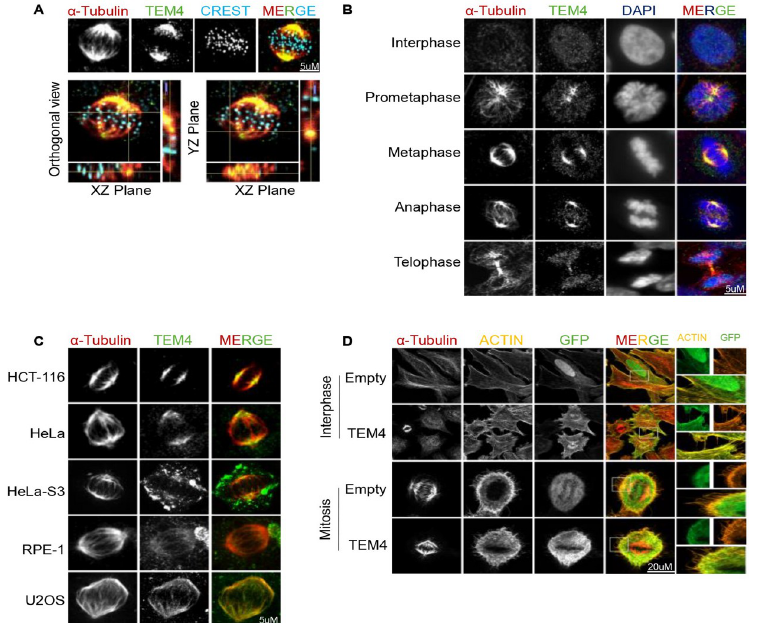
Fig 1. The TEM4 antibody decorates the mitotic spindle. A: Representative immunofluorescence image of a metaphase HCT-116 cell. Cells were synchronized in mitosis after 10 hours of release from double thymidine block and fixed for 10 minutes with PTEMF buffer. Fixed cells were stained with anti-TEM4 (green), anti- α -tubulin for the spindle microtubules (red) and CREST serum for the kinetochores (blue). In the lower panel, orthogonal sections of the maximum intensity projections of the same cell are shown. Scale bar = 5 μ m. B: Representative immunofluorescent images of TEM4 antibody staining in HCT-116 cells during cell cycle progression. Fixed cells were stained with anti- TEM4 (green), anti- α -tubulin (red), and DNA was stained with Hoechst (blue). Cell cycle stages are indicated to the left of each image and merged images are shown in the right most panel. Scale bar = 5 μ m. C: Immunofluorescence of metaphase spindles in different cell lines lines showing staining at the mitotic spindle. Cells were synchronized in mitosis after 10 hours of release from double thymidine block and fixed for 10 minutes with PTEMF buffer. Fixed cells were stained with anti-TEM4 (green) and anti- α -tubulin for the spindle microtubules (red). The different cell lines are indicated to the left of each image. Scale bar = 5 μ m. D: HeLa T-REx cells were left synchronous (upper panel) or were synchronized in mitosis (lower panel) after 30 minutes release from RO-3306. Cells expressing empty- GFP, or GFP-TEM4 were stained with anti-GFP (green), anti- α -tubulin for the spindle microtubules (red) and phalloidin-Atto 565 for F-actin (Yellow). Scale bar = 20 μ